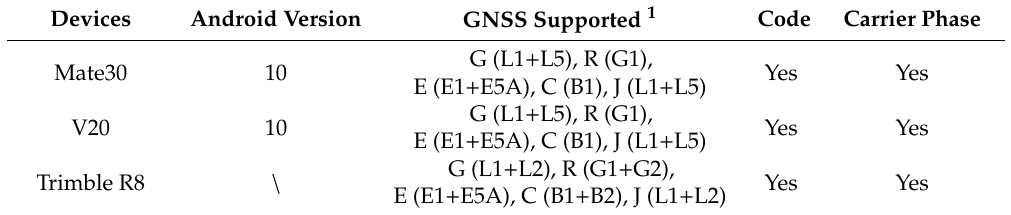
Table 1. Performance features of the Mate30, the V20 smartphones and Trimble R8 geodetic receiver. Devices Android Version GNSS Supported 1 Code